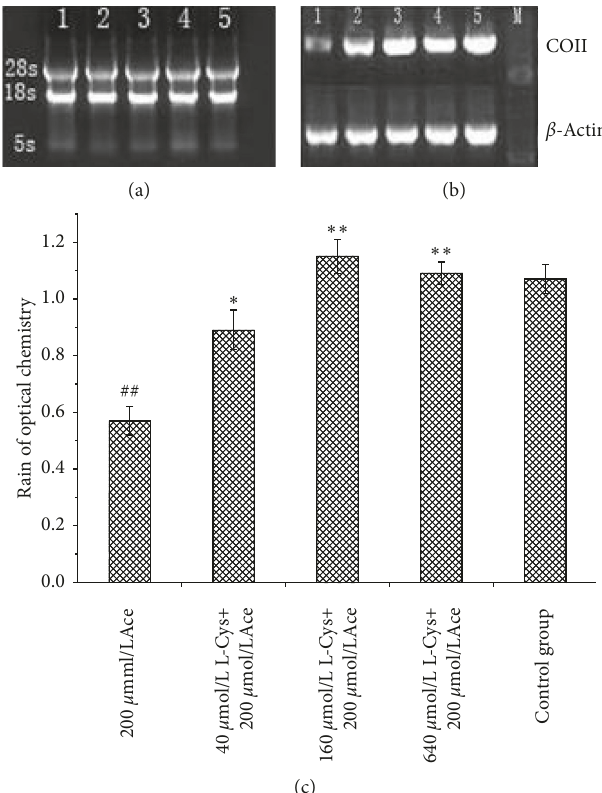
Figure 3: Electrophoretogram of RNA (a) and influence of L-Cys on the COII mRNA expression of the A549 cells damaged by acetaldehyde (b, c). Lanes 1 to 5 represent 200 μ mol/L acetaldehyde, 40 μ mol/L L-Cys +200 μ mol/L acetaldehyde, 160 μ mol/L L-Cys +200 μ mol/L acetaldehyde, 640 μ mol/L L-Cys+200 μ mol/L acetaldehyde, and 0 μ mol/L L-Cys +0 μ mol/L acetaldehyde (control group), respectively. Data are presented as the mean ± S.E. n � 6 − 12; ## P < 0 . 01, with respect to the control group; ∗ P < 0 . 05 and ∗∗ P < 0 . 01 with respect to the 200 μ mol/L acetaldehyde